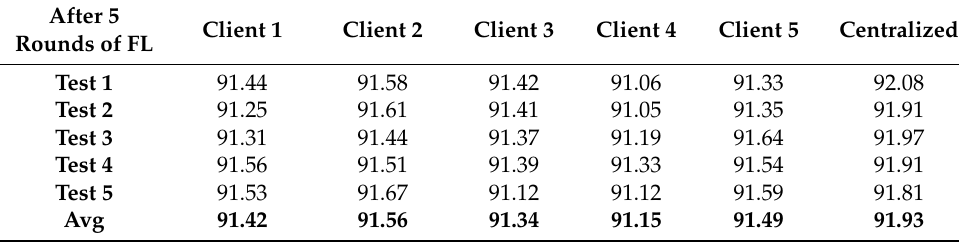
Table 1. Comparison of accuracy between different clients and centralized model. After